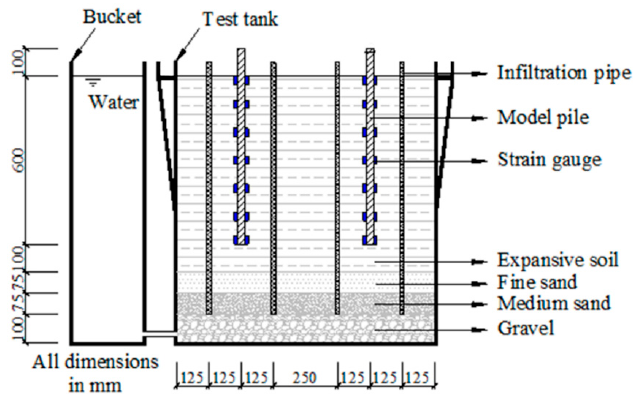
Figure 7. Schematic of immersion system.